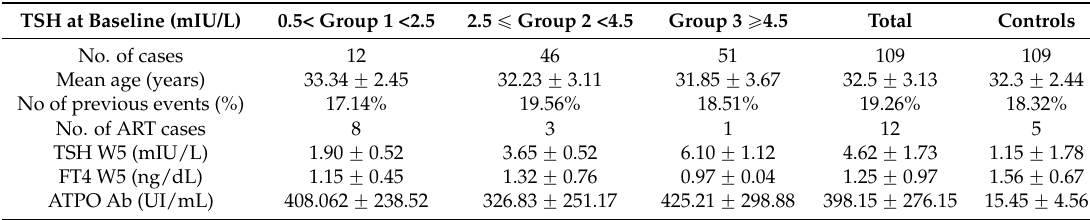
Table 2. Characteristics of study groups.